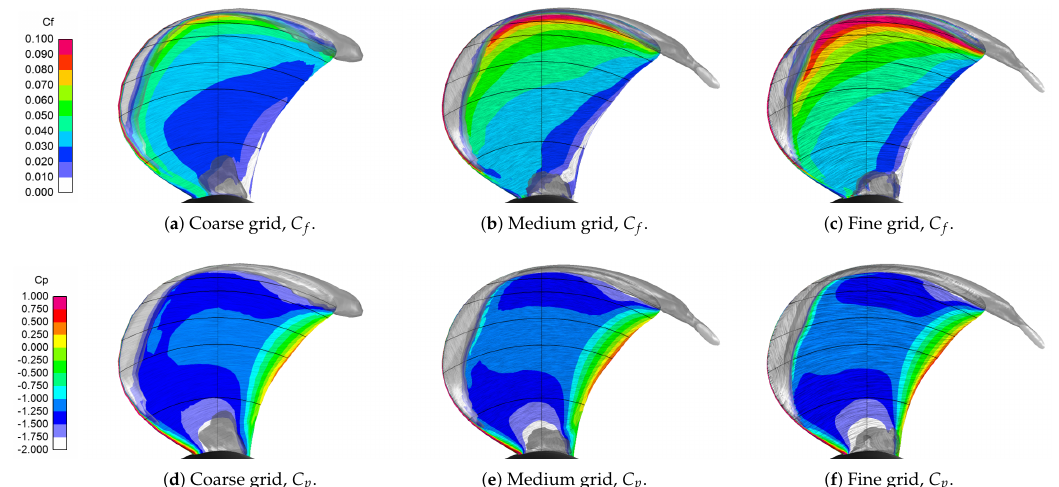
Figure 17. Comparison of near-blade cavitation results with different grid densities. Top row: skin-friction coefficient. Bottom row: pressure coefficient. Model-scale simulations for PPTC Case 1.